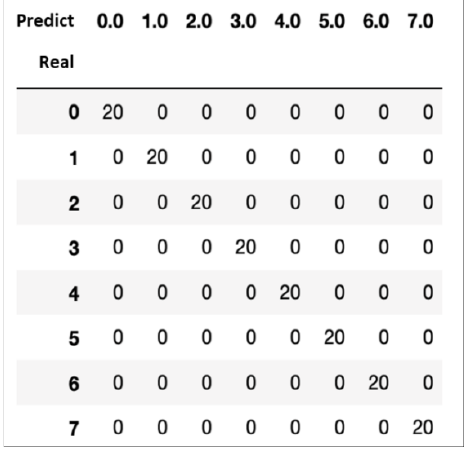
Table 3. Confusion matrix for testing results obtained using RSSI data in Figure 12